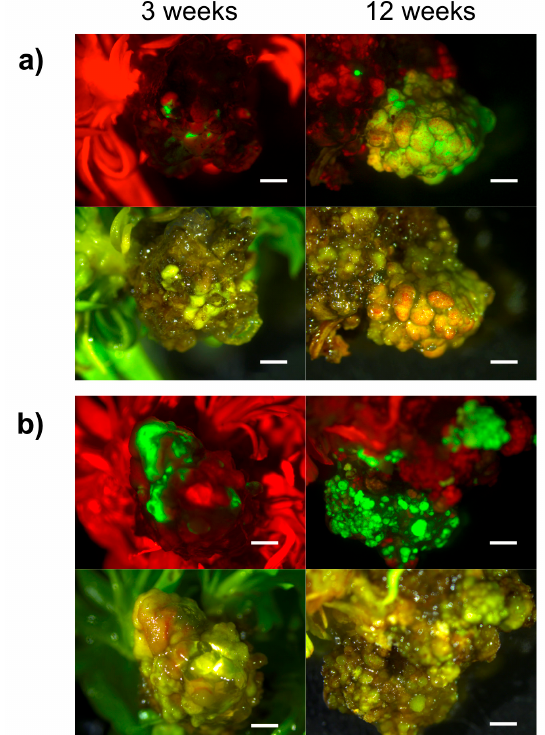
Figure 3. Hansen 536 GFP fluorescing spots and/or Lzs detected on MB slices at three weeks and 12 weeks after co-culture on medium with 17 μ M Kan: ( a , b ) MB slices obtained from two independent MBs presenting Lzs of GFP expression actively growing within 12 weeks of culture. Uniform bright green fluorescence was observed under UV light. Upper and lower panels show images taken under UV and white light, respectively (bar = 2 mm).